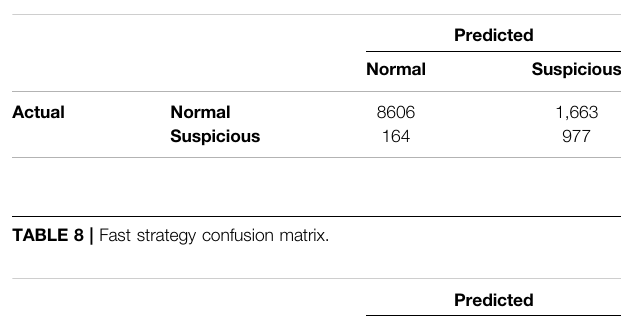
TABLE 7 | Safe strategy confusion matrix.